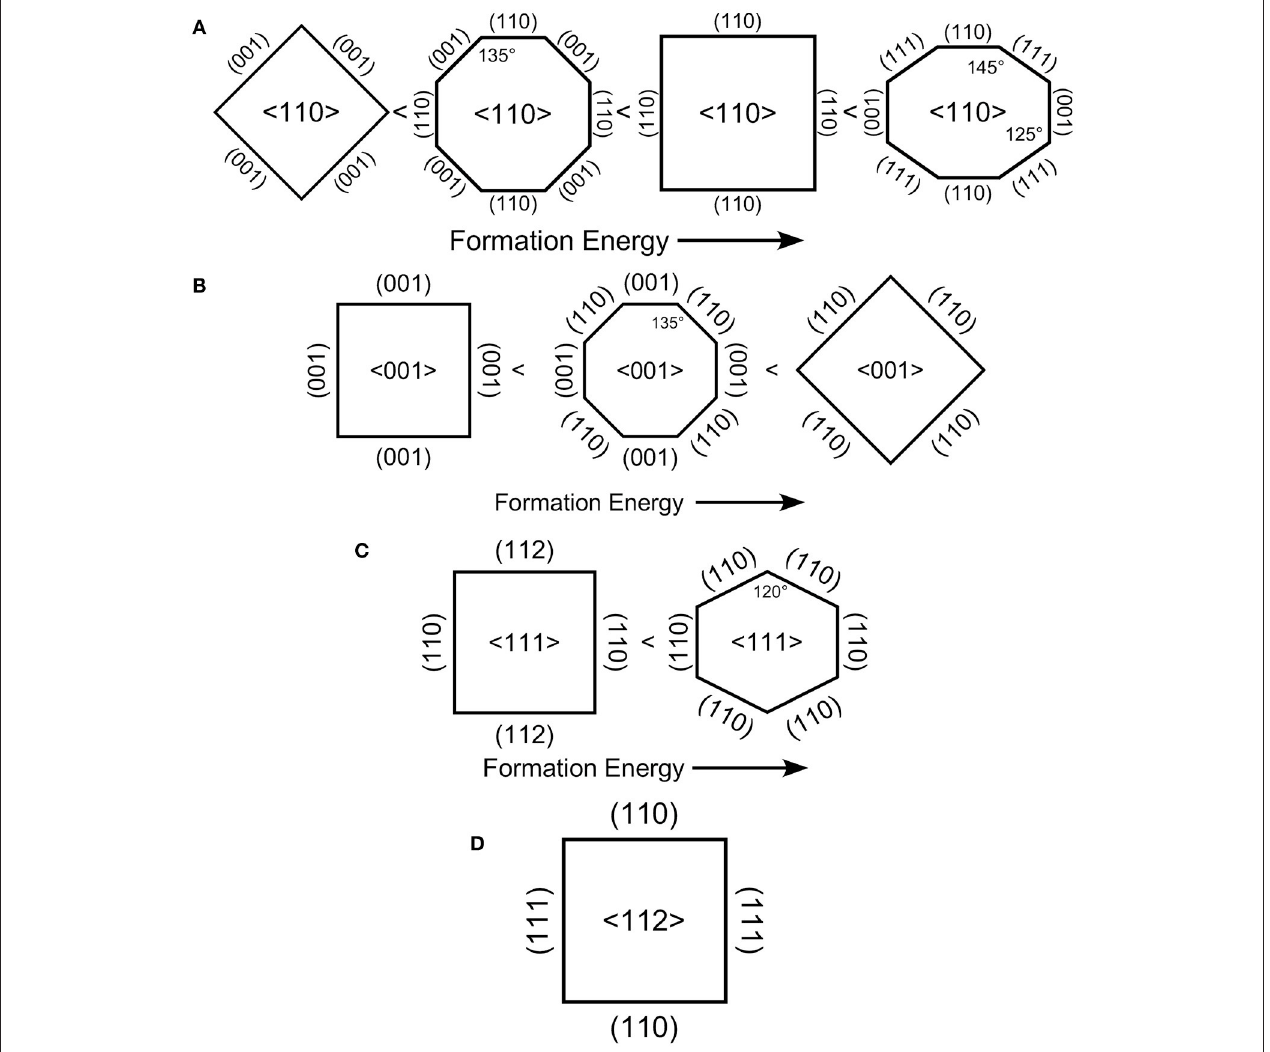
FIGURE 8 | Viewed down the long axis of a vertical pore (or pillar), the crystallography of the sidewalls is shown. For four directions (A) h 110 i , (B) h 001 i , (C) h 111 i , (D) h 112 i , vertical pores can be formed. Depending on the crystallography of the sidewall terminations, these ideal pores would exhibit facets that form either rectangular, hexagonal or octagonal cross-sections. A vertical pore in the direction is not possible as only two planes make right angles with